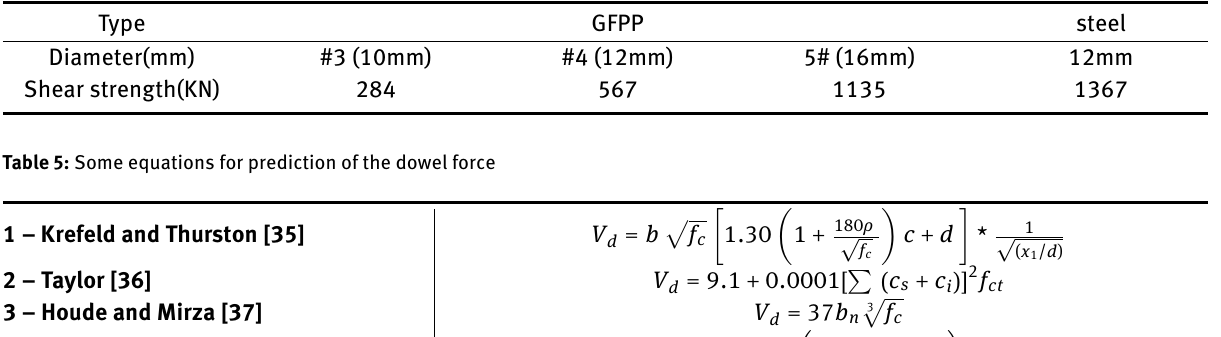
Table 4: Results of dowel action test